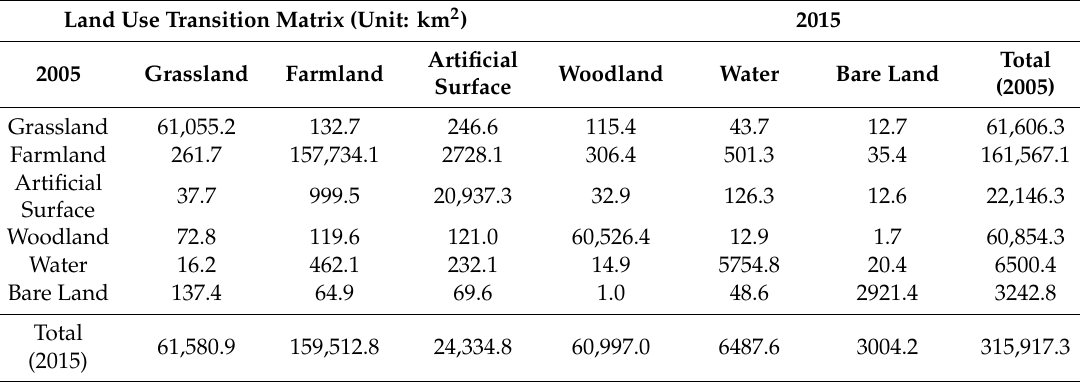
Table 2. Land use transition matrix in 2005 and 2015 in the Haihe River Basin. Land Use Transition Matrix (Unit: km 2